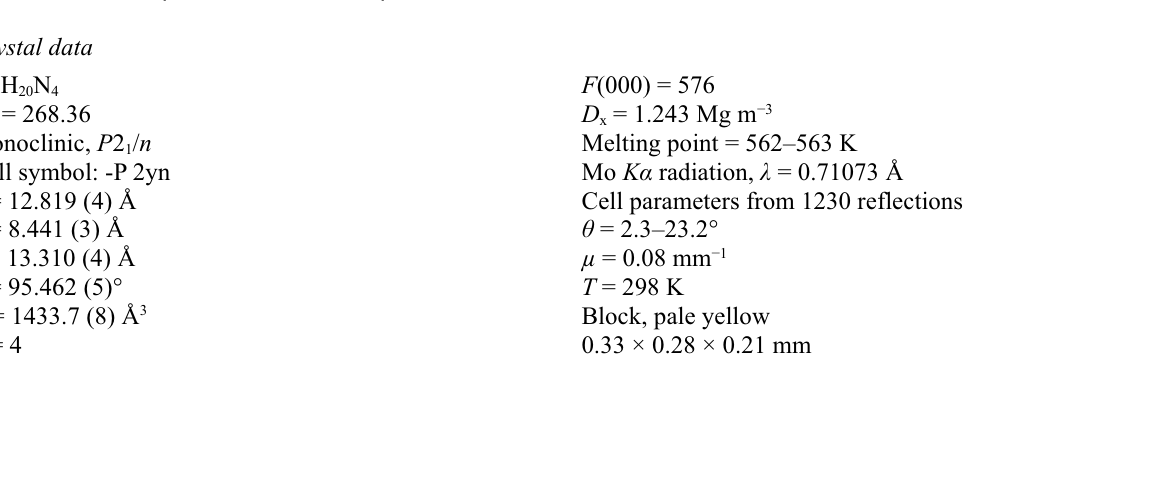
The molecular structure of the title molecule, with the atom-numbering scheme. Displacement ellipsoids are drawn at the 50% probability level [symmetry code (A): -x, -y,